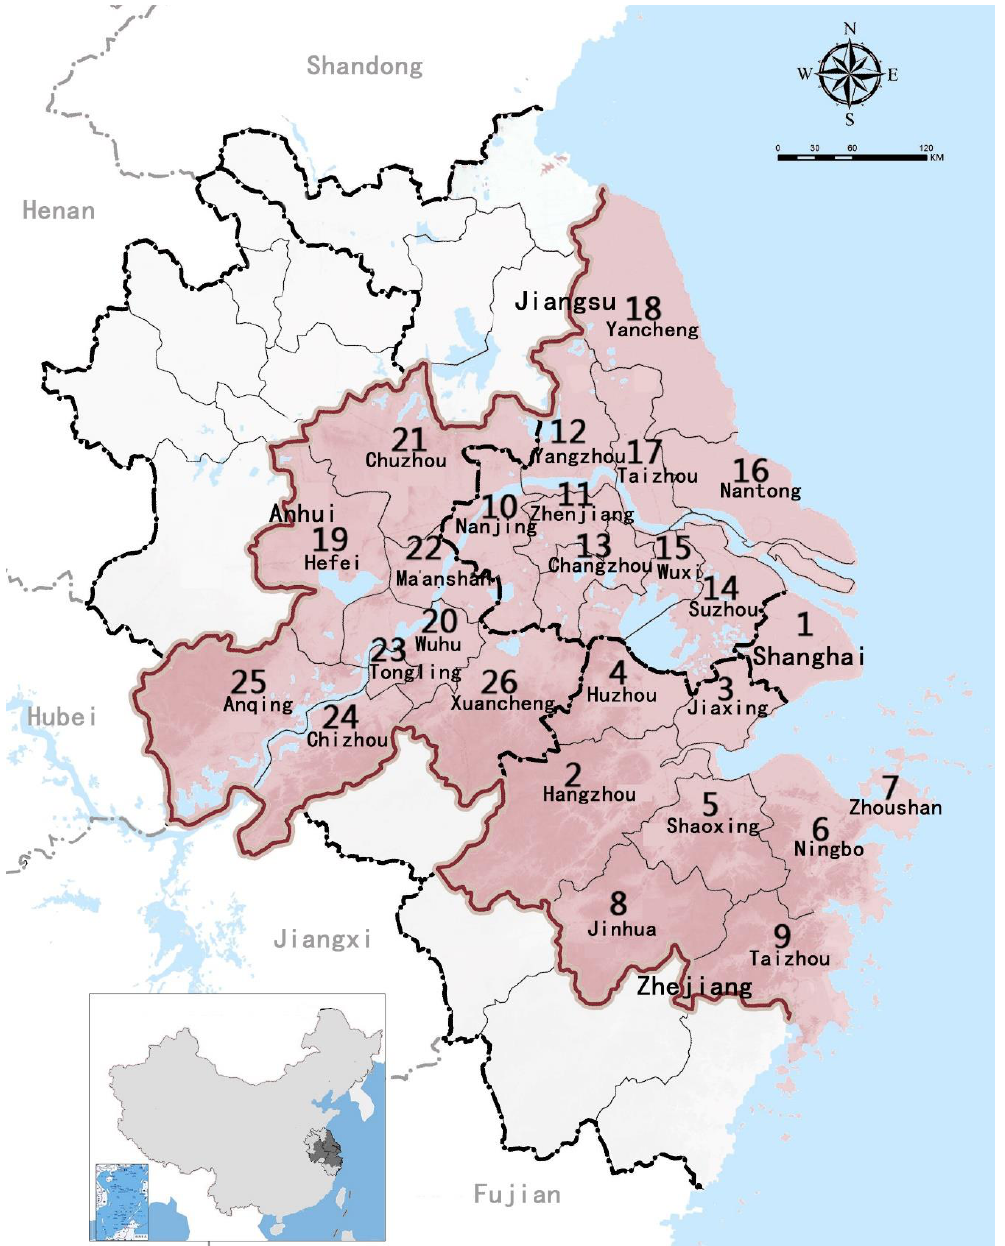
Figure 2. Geographical locations and numbers of the YRDUA’s twenty -six cities. Table 1. Classification of city size in the YRDUA.